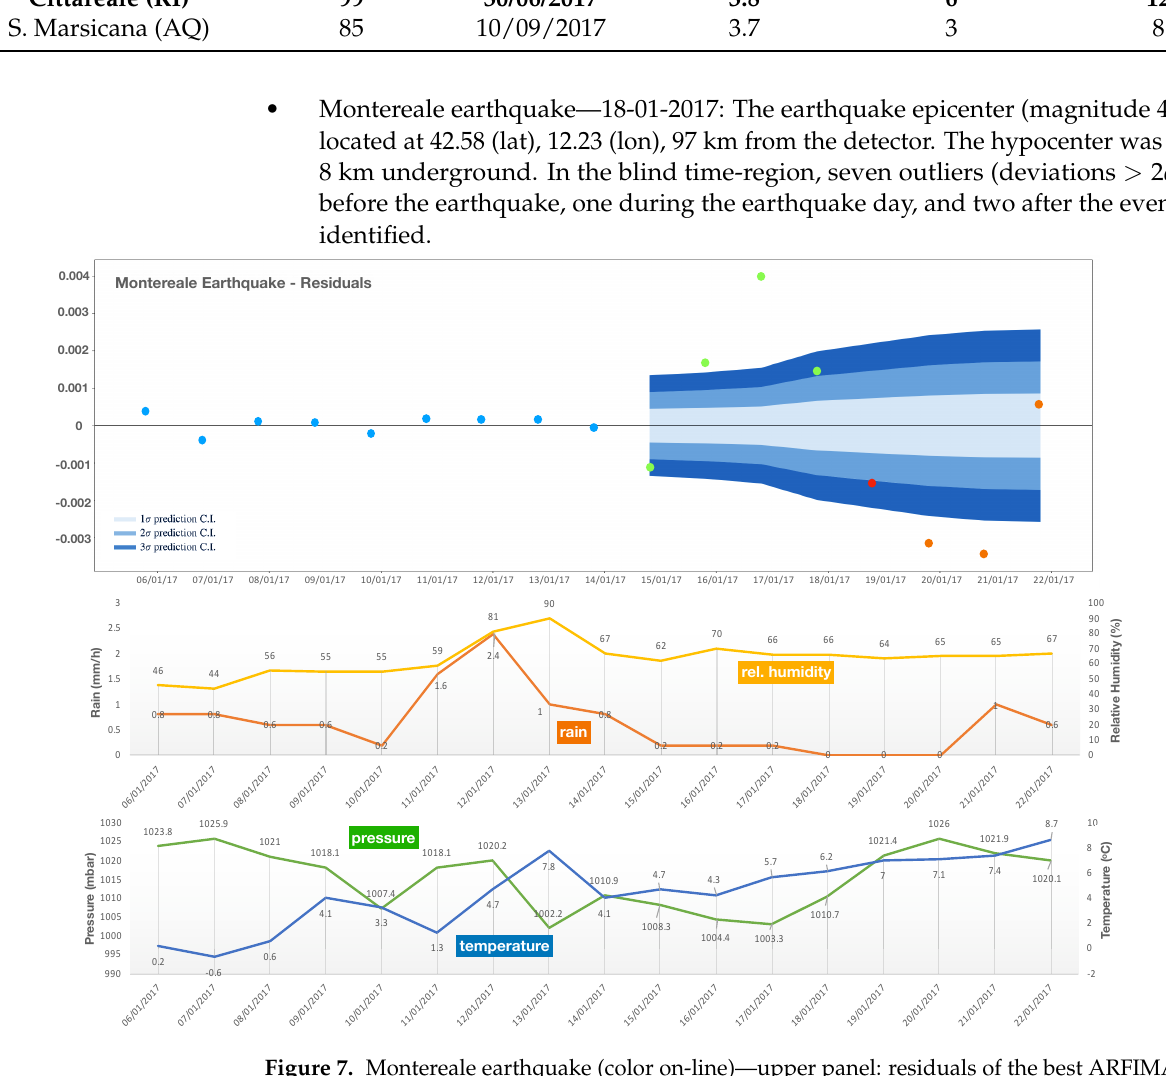
Figure 7. Montereale earthquake (color on-line)—upper panel: residuals of the best ARFIMA model. Blue points correspond to the dose rate background data and green points to the pre-shock events; the red point is the earthquake event and the orange points represent aftershock events. The confidence level bands for coverage factor k = 1, 2, 3 (from the lightest to the darkest blue) are drawn in the blind time region. In the middle and lower panels the relative humidity, rainfall, temperature, and pressure time series are shown, as indicated by the respective